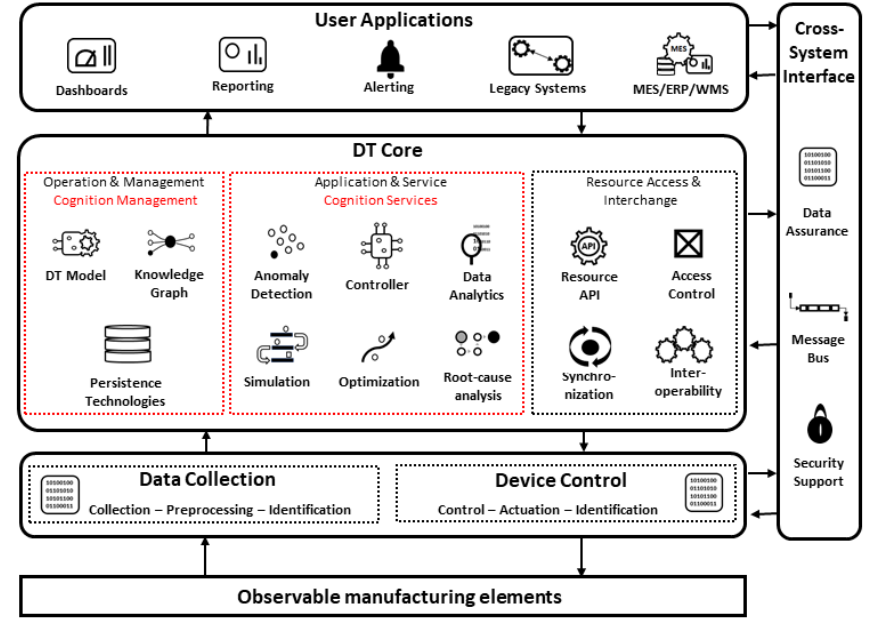
Figure 2. Conceptual